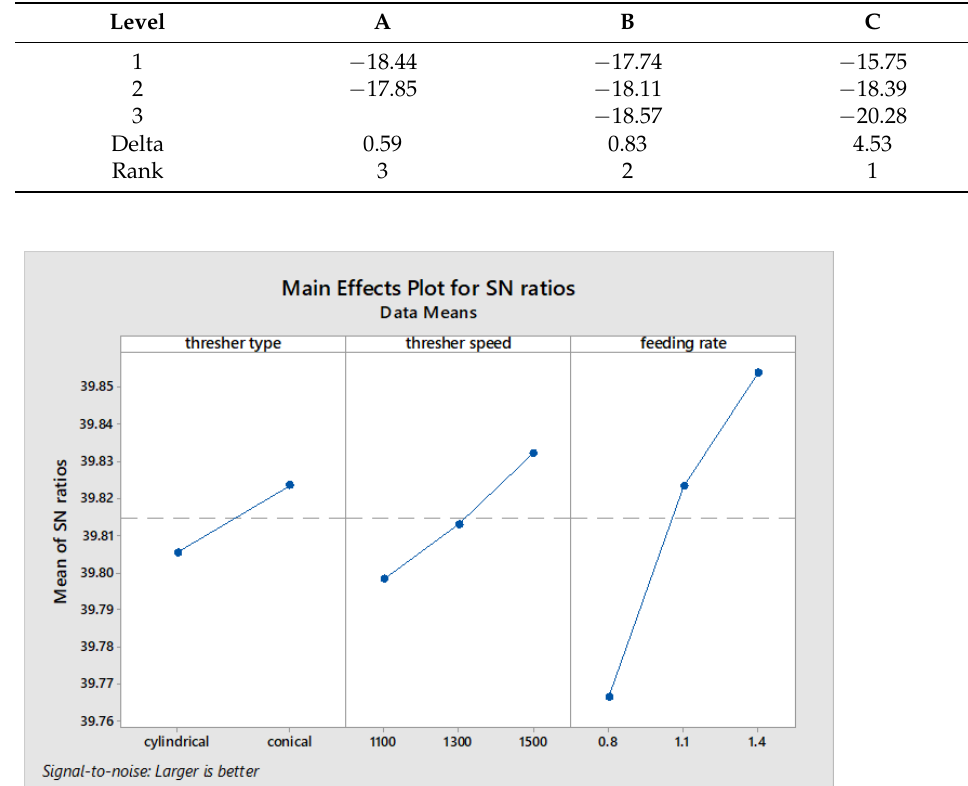
Table 5. Response table for signal to noise ratios for threshing efficiency (larger is better). Table 7. Response table for signal to noise ratios for power (smaller is better).